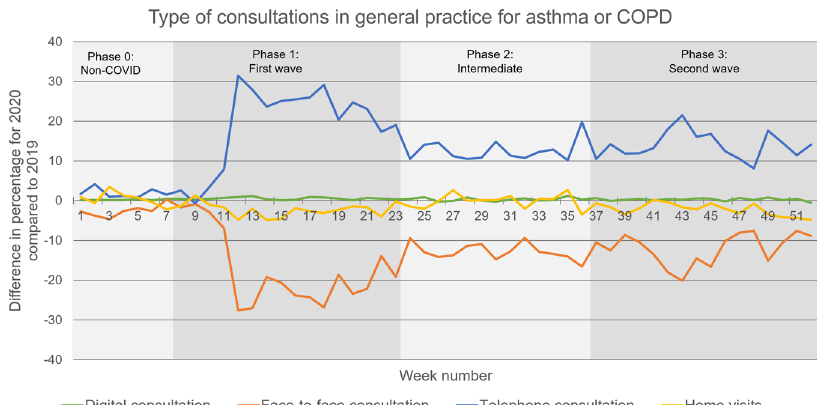
Fig. 2 Type of consultations in general practice for asthma or COPD. The difference in type of consultation in general practice for asthma or COPD, 2020 compared to 2019.